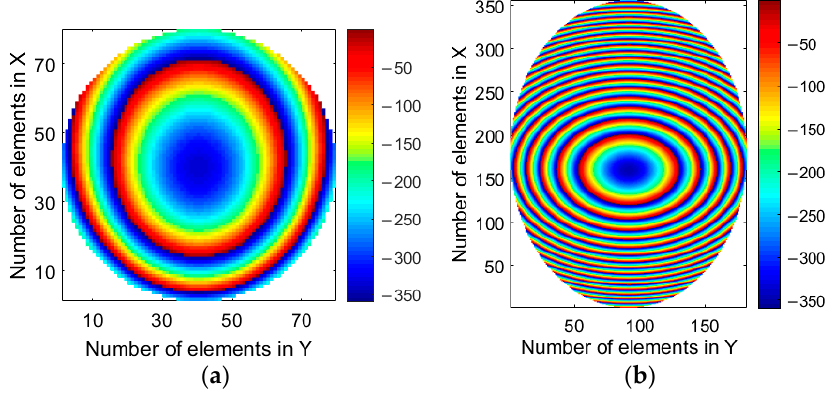
Figure 4. Monofocal phase distributions (in degrees) on ( a ) the sub-RA and ( b ) the main RA.